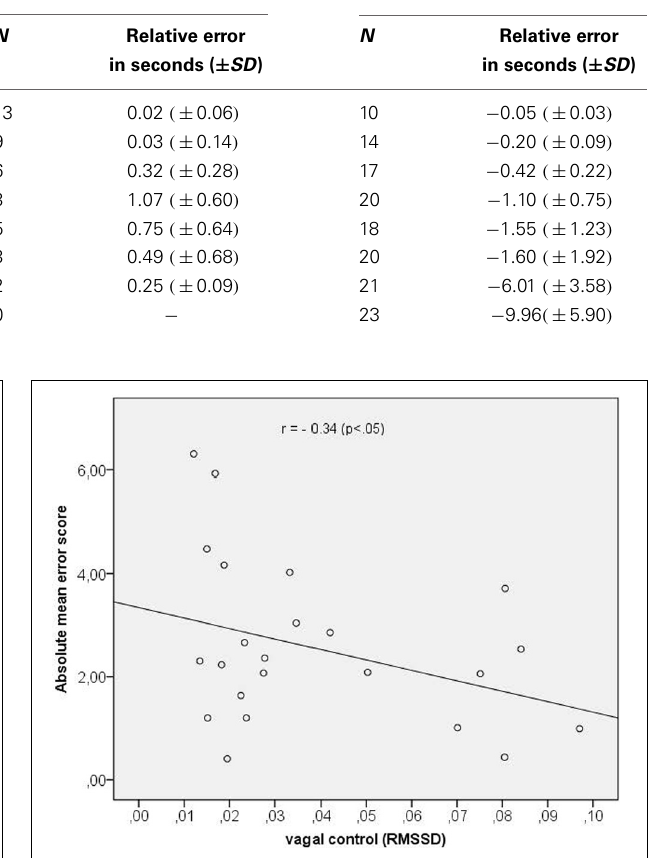
FIGURE 3 | Scatterplot between vagal control (as indexed by the RMSSD) and absolute mean error score.